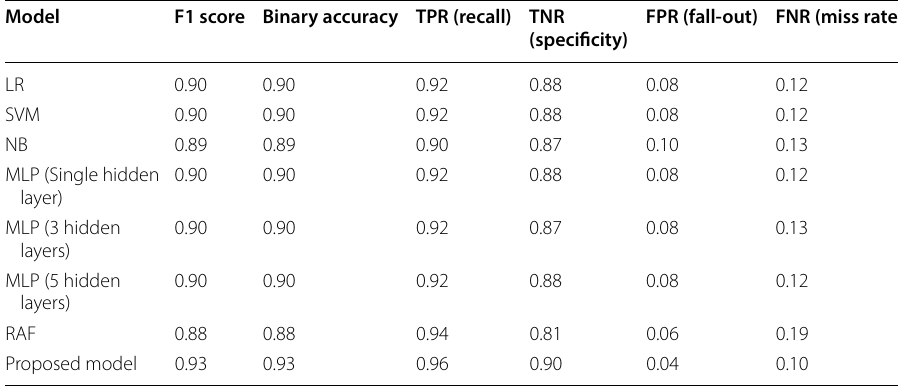
Table 7 Model performance comparison—metric scores Model